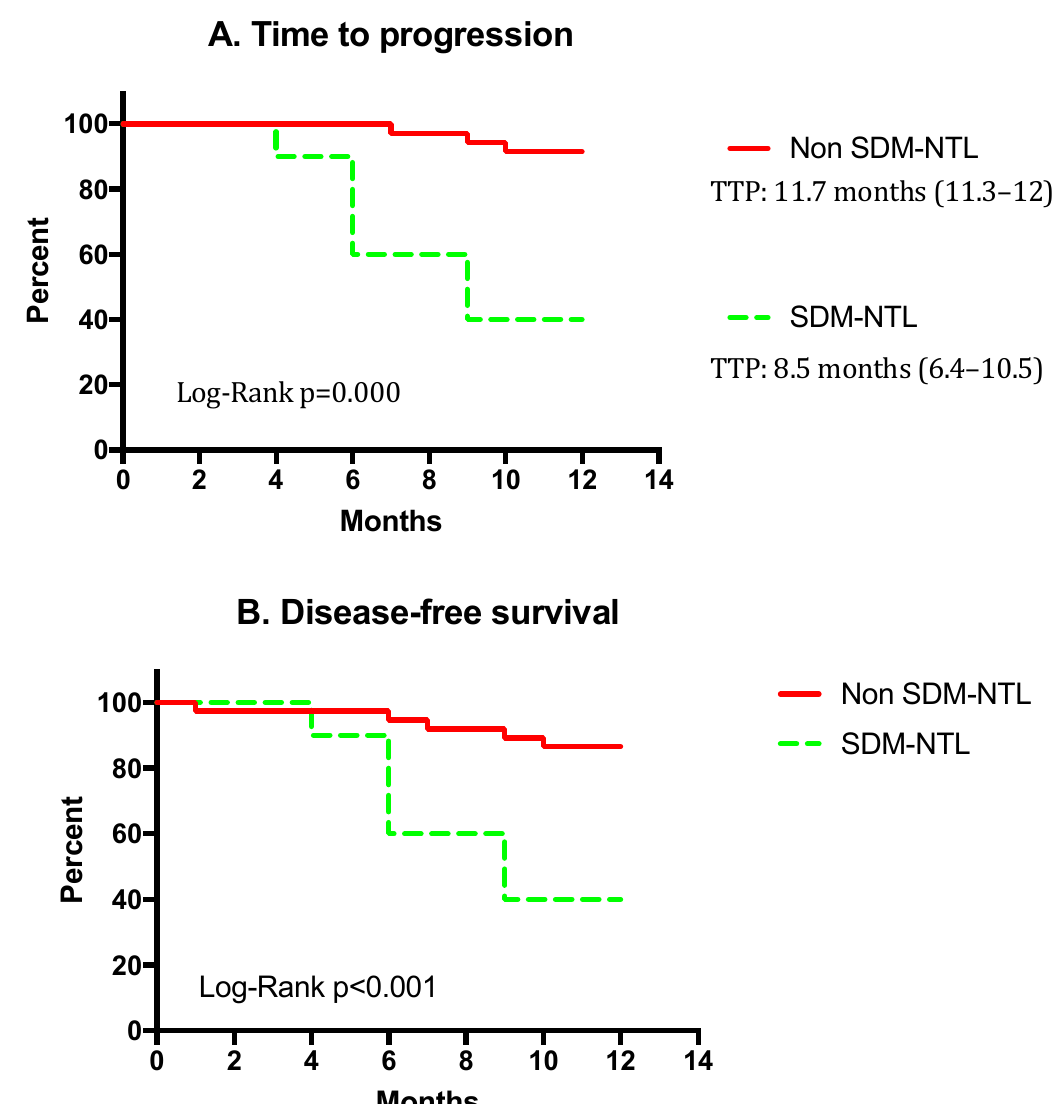
Figure 3. Kaplan Meier curves for ( A ) time to progression, and ( B ) disease free survival time. Abbreviations: SM, genetic alterations ( EGFR and / or KRAS ) observed both in the tumor and the non-tumoral lung parenchyma. Non-SM, genetic alterations shown only by the tumor.